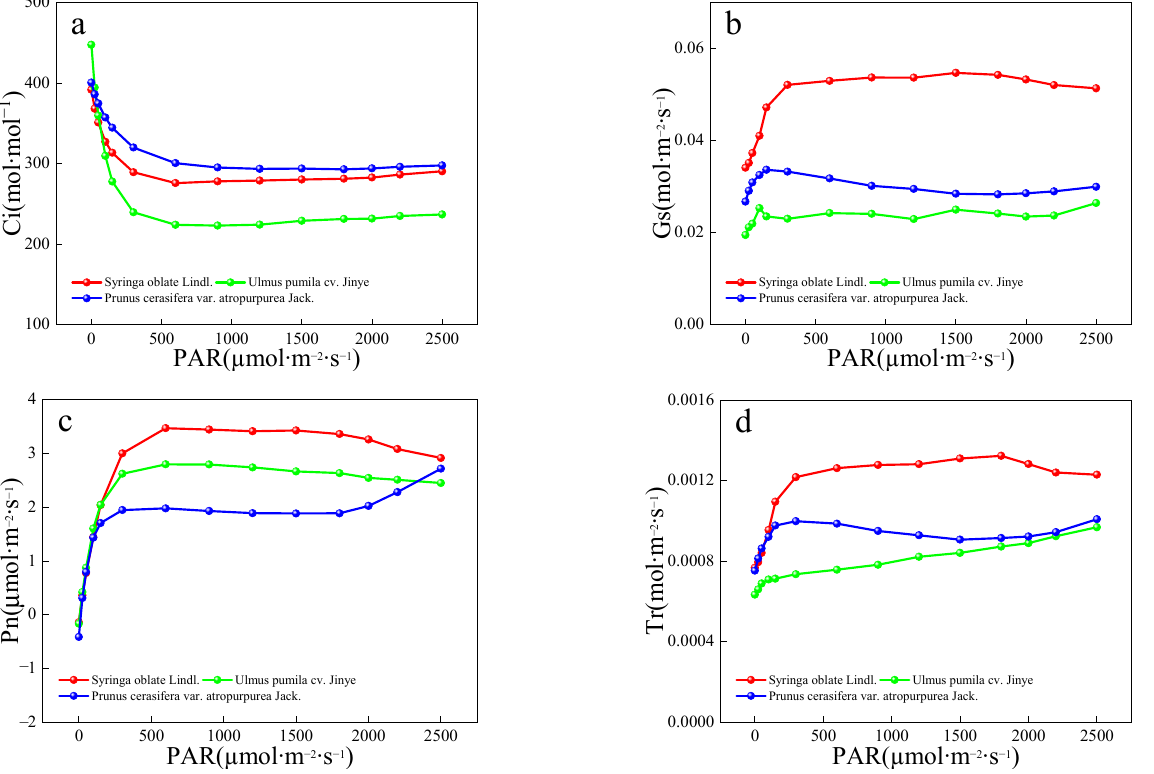
Figure 2. Light response curves under SO 2 stress (9 Sept). ( a ) Intercellular CO 2 concentration, Ci; ( b ) stomatal conductance, Gs; ( c ) net photosynthetic rate, Pn and ( d ) transpiration rate, Tr.